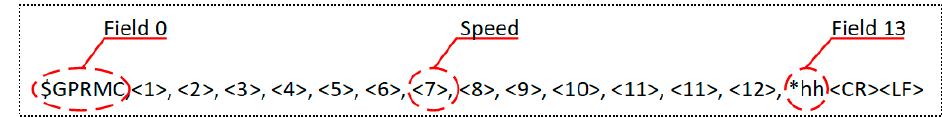
Figure 6. GPRMC frame